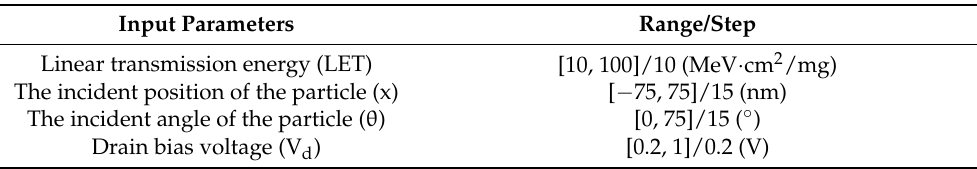
Table 2. Input parameters of the deep neural